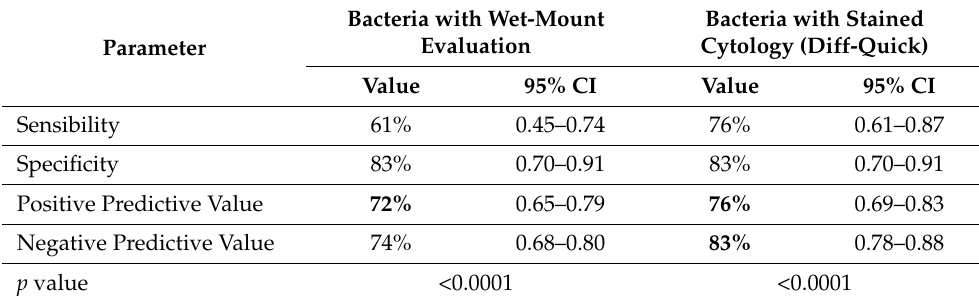
Table 2. Comparison between wet-mount evaluation and stained cytology.